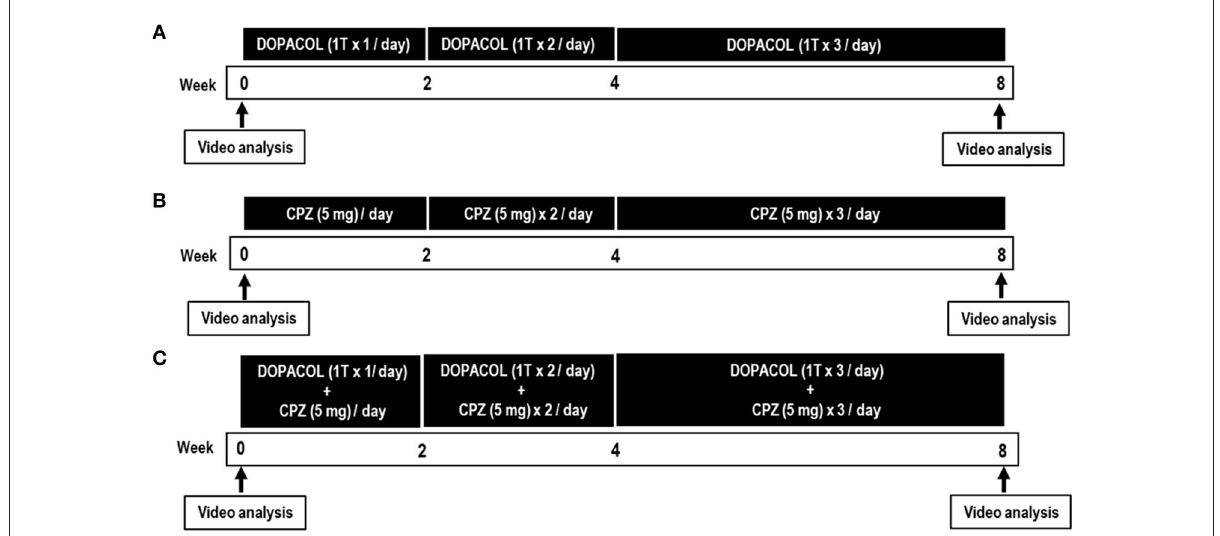
FIGURE2 Timetable for the drug challenge tests with Dopacol tablets L50 TM (DOPACOL) ( A ), chlorpromazine (CPZ) ( B ), and DOPACOL + CPZ ( C ). T, tablet. Clinical evaluations and video recordings were performed 1 day before (pre-treatment) and 8 weeks after (post-treatment) the initial administration of the